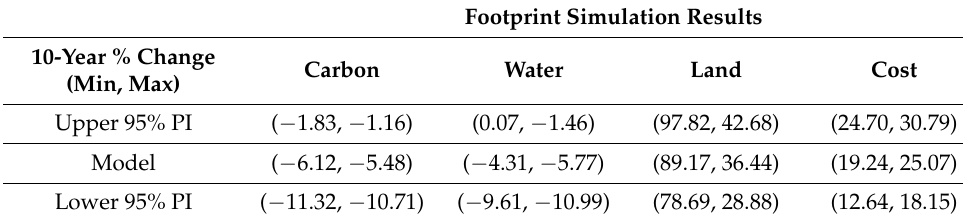
Table 5. Sustainability Assessment